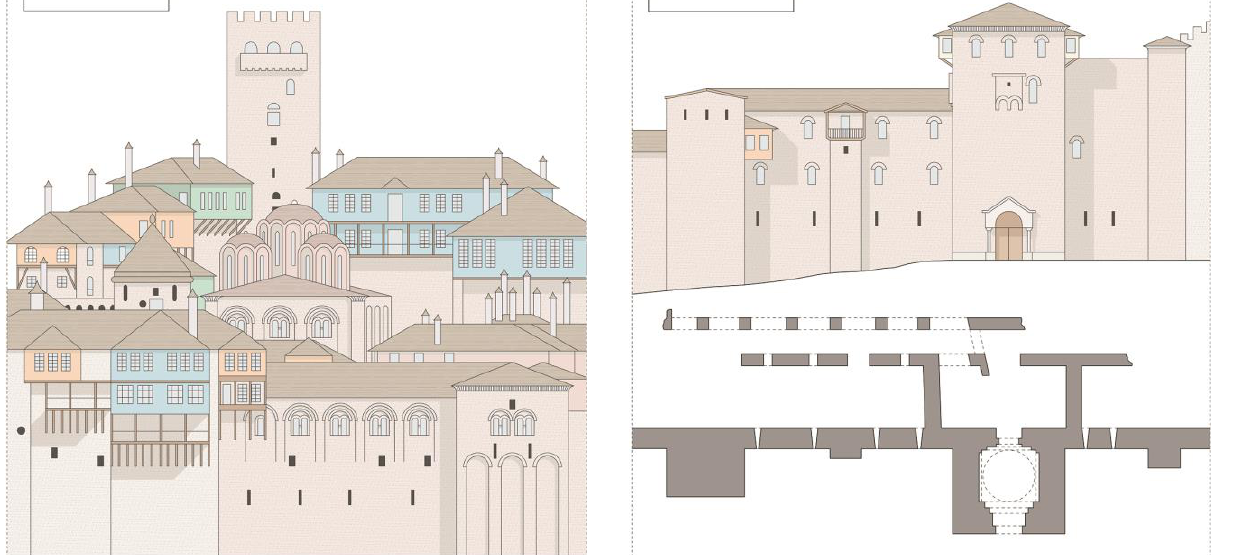
Figure 14 . The Monastery of Dochiariou. Detail of the western elevation.